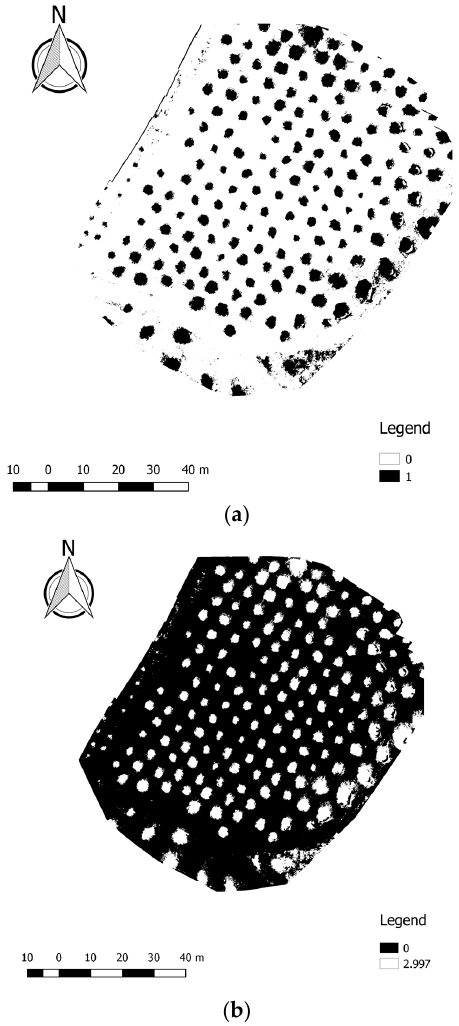
Figure 5. ( a ) Supervised classification result; and, ( b ) Unsupervised classification result, for olive crop.